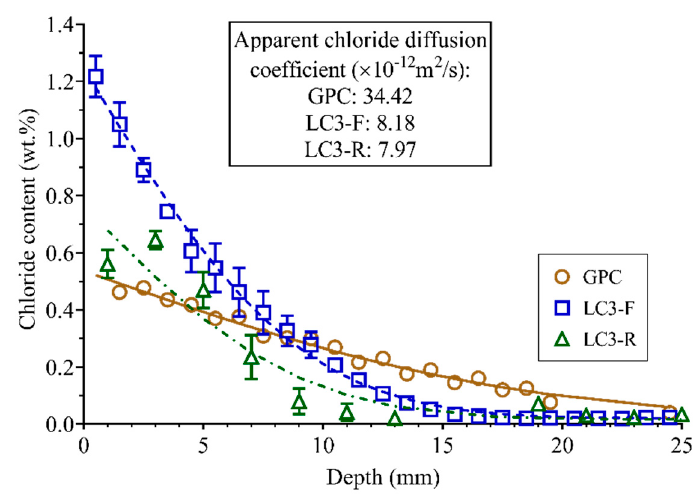
Figure 6. Total chloride content profile and chloride diffusion coefficient from the bulk diffusion test (ASTM C1556).